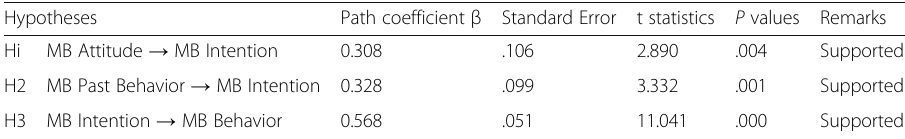
Table 5 Results of Structural Model